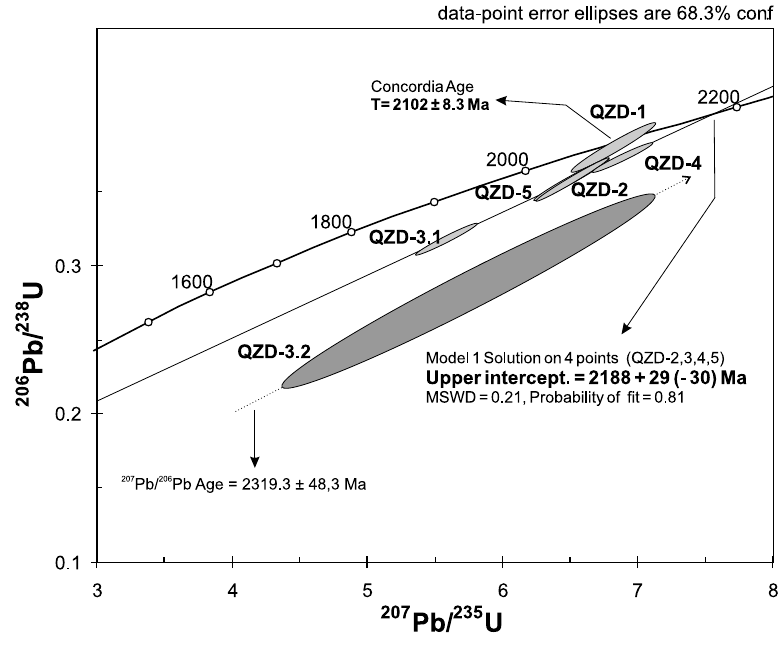
Fig. 6 – SHRIMP U-Pb diagram of sample CAWT02 (PC-18E – M-II facies) of the Glória quartz-monzodiorite. See text for